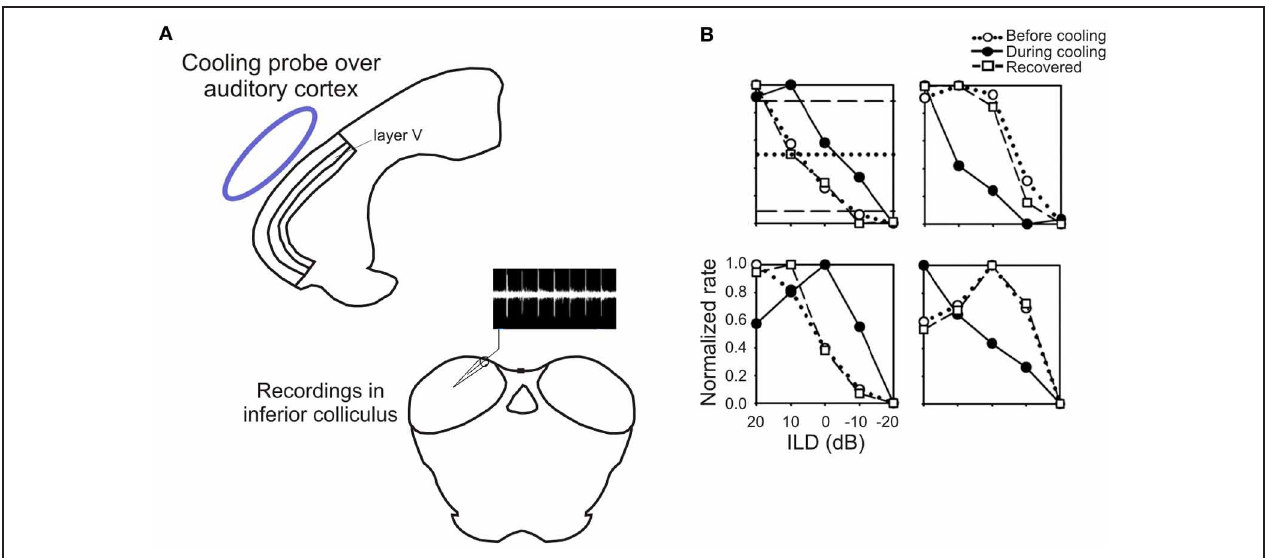
FIGURE 8 | Inactivation of the auditory cortex alters sensitivity to interaural level differences (ILD) in the inferior colliculus. (A) Schematic of the experimental setup, showing a cooling probe (blue) above the auditory